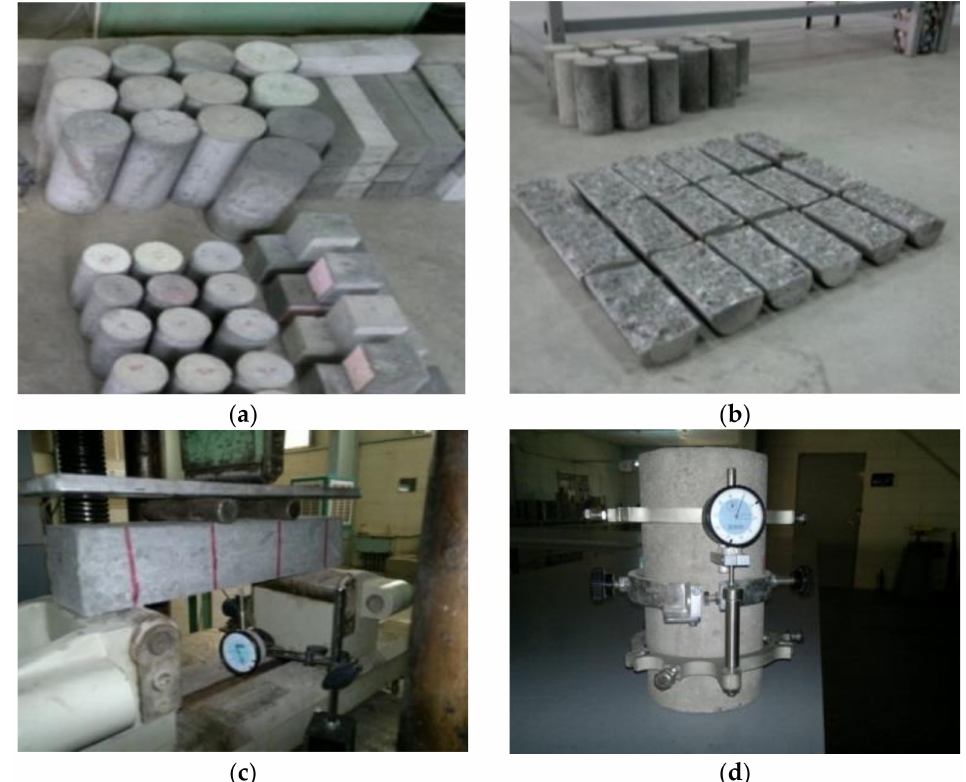
Figure 2. Mechanical properties tests ( a ) various size and shape specimens for compressive strength, ( b ) cylinders in splitting tensile strength test, ( c ) flexural strength test of concrete specimens, and ( d ) testing modulus of elasticity for Ø150 mm